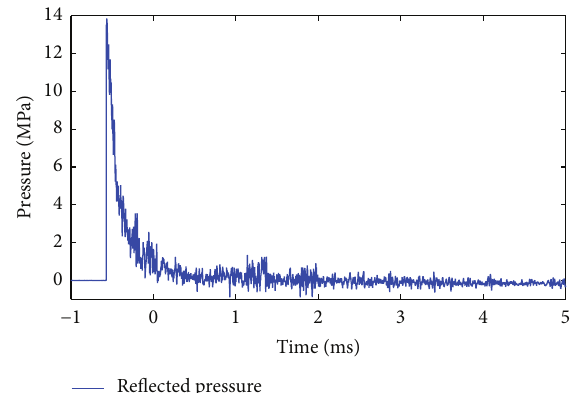
Figure 5: Reflected pressure measured at 2 mm after the EDST end generated by detonating 10g of C4set at a stand-offdistance of 5 mm from the entrance of the EDST.